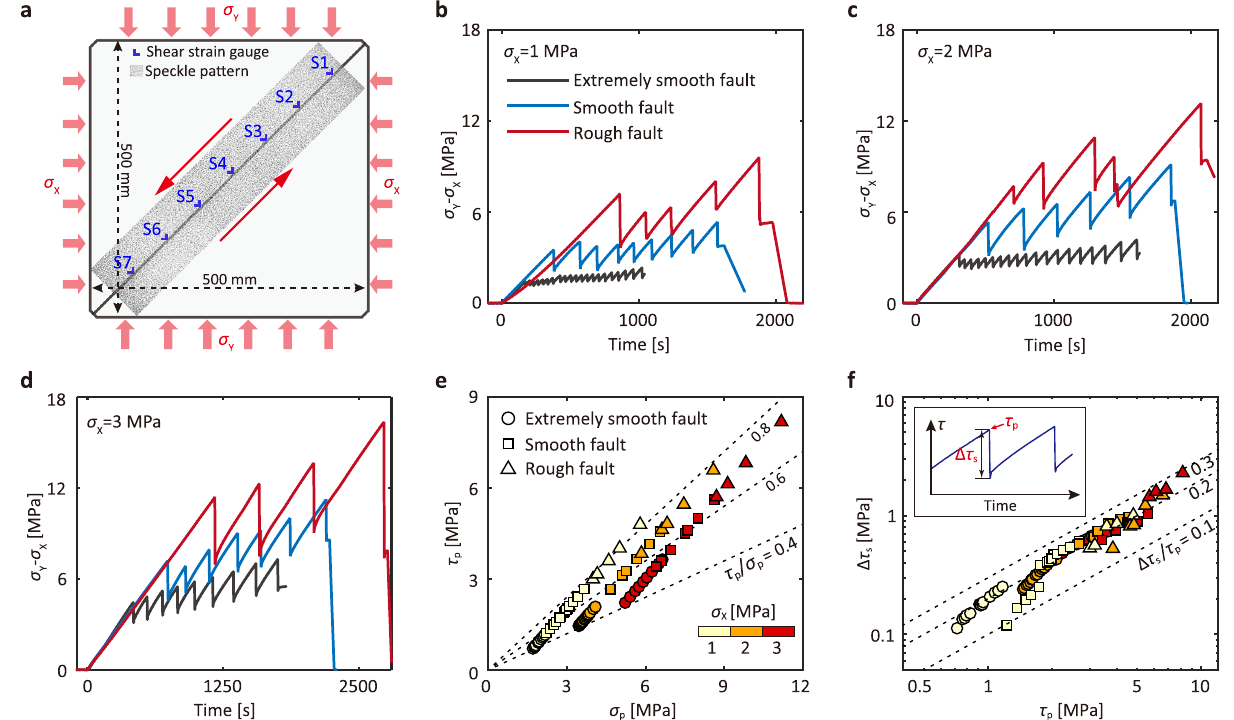
Fig. 1 | Stick-slip events mimicking natural earthquakes. a Schematic of laboratoryearthquakemodel.Thelaboratoryfault,withtotallengthof650mmand observation window of 550mm, is subjected to biaxial loading. The fault slip directions are indicated by red arrows. b – d Differential stress ( σ Y (cid:2) σ X ) as a func- tion of time at increasing horizontal stress ( σ X =1, 2, and 3MPa) on extremely smooth (black), smooth (blue), and rough (red) faults. e Stress state, global peak shearstress τ p as a function ofpeak normalstress σ p , atthe onsetofinstability for